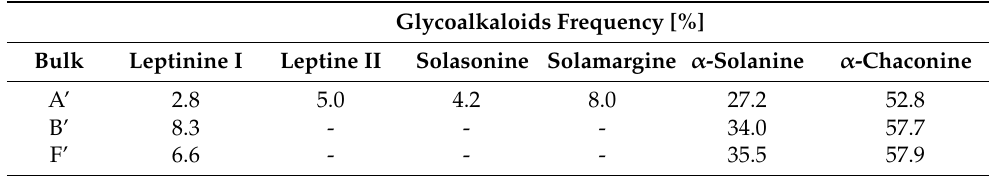
Table 4. Glycoalkaloids recognized in the bulk samples A’, B’, and F’.